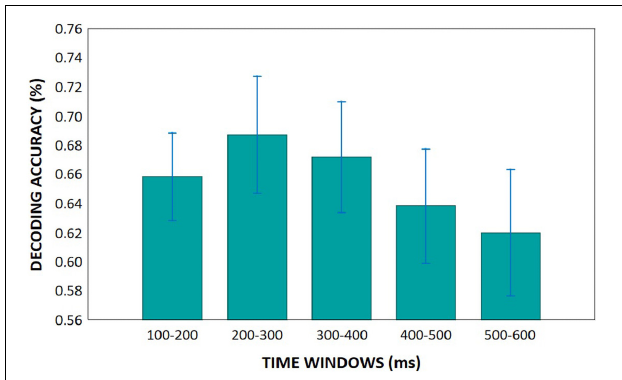
FIGURE 10 | Mean decoding accuracies in the five analyzed time windows. Vertical bars denote 0.95 confidence intervals.